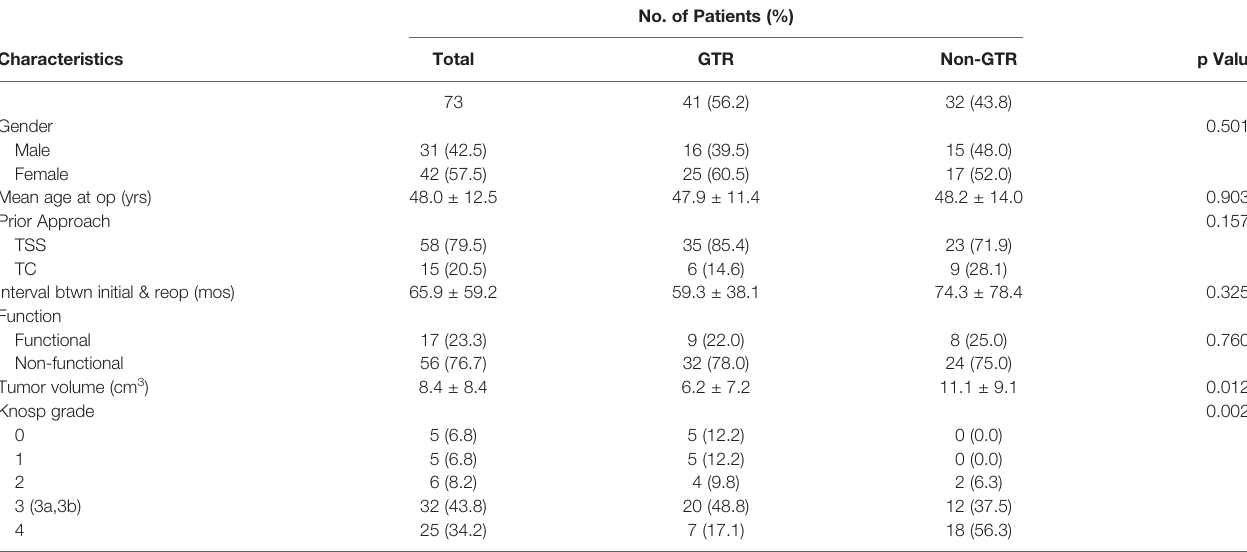
TABLE 2 | Preoperative characteristics of rrPAs classi fi ed by GTR. Characteristics